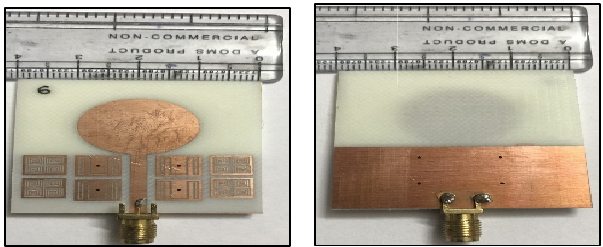
Figure 18. Designed UWB-CMSA with hybrid EBG near the feed.